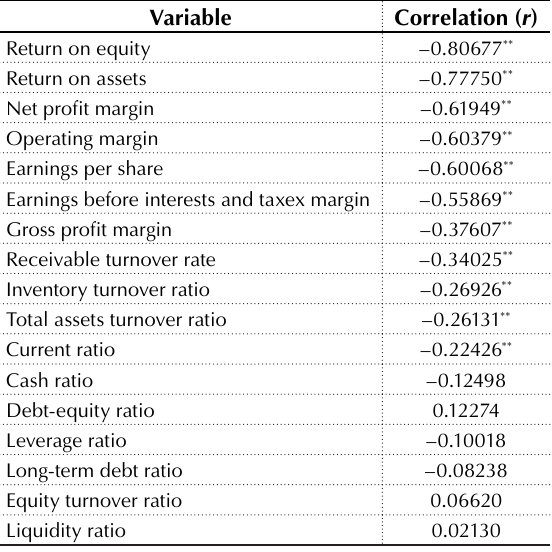
Table 3. The correlation between the I 2 -distance